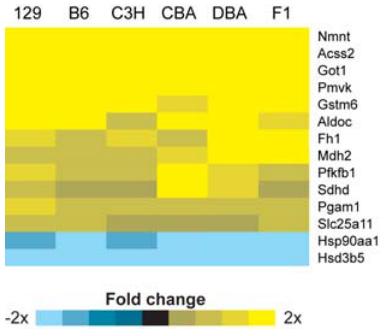
Figure 2. CR-induced change in expression from the microarray data for the 14 biomarkers of CR in mouse liver. The fold change in expression in response to CR is shown for each strain; significant changes are highlighted with yellow or blue